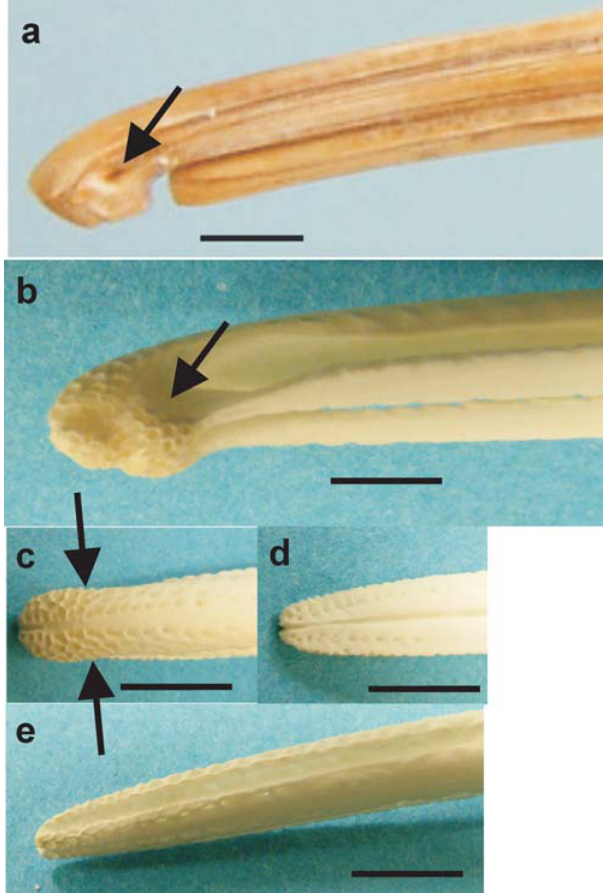
Figure 5. Nostrils and sensory pits at the bill tip of kiwi. a, Lateral view of the bill tip of a museum skin specimen of A. mantelli with the rhamphotheca intact and showing the position of the nostril (arrow). b– e , bones of the bill tip of A. mantelli . b latero-ventral view of the maxilla showing the complex blunt shape of the bill tip whose surface is covered with closely packed sensory pits; the approximate position of the nostril is indicated (arrow). c , dorsal view of the maxilla with the approximate positions of the nostrils indicated (arrows), d , dorsal view of the mandible showing that sensory pits are found at the bill tips within the mouth, e , latero-ventral view of the mandible showing that closely packed sensory pits cover the outer surface of the lower jaw. All scale bars 5